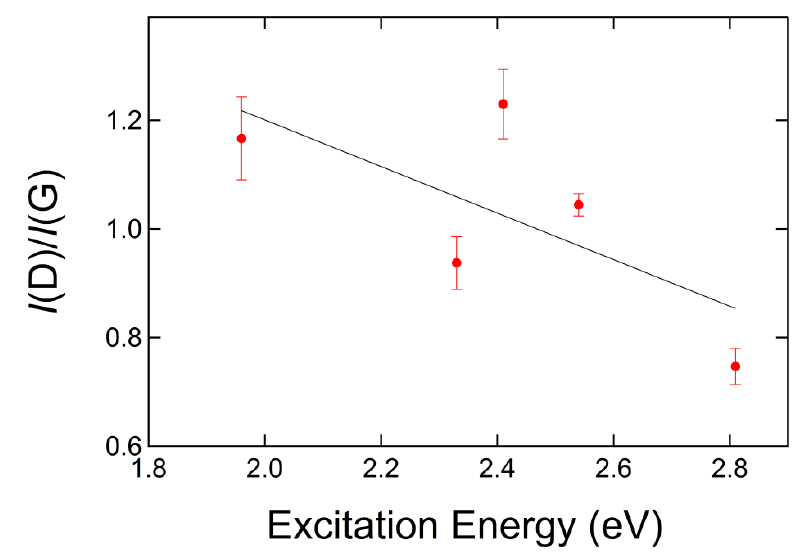
Figure 5. The ratio of the intensities of the D and G peaks as a function of excitation energy.